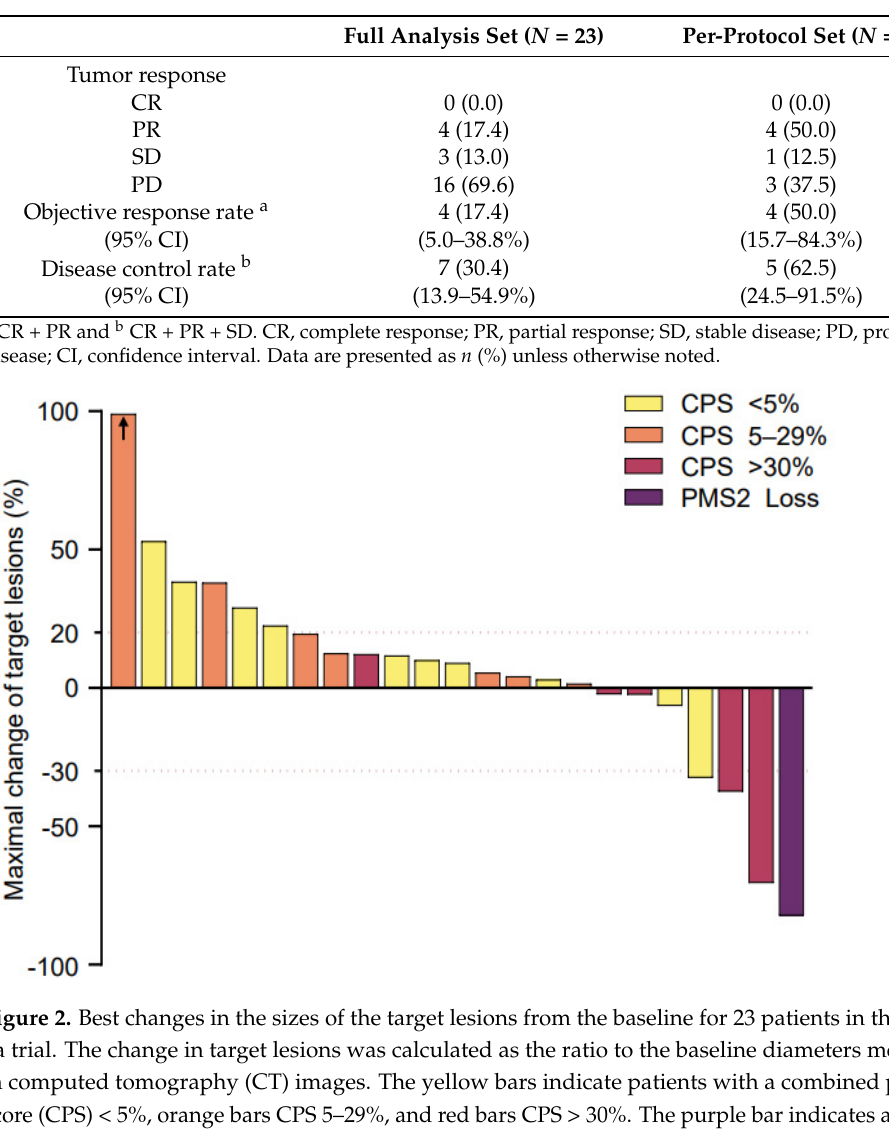
Table 1. Objective response rate and disease control rate.